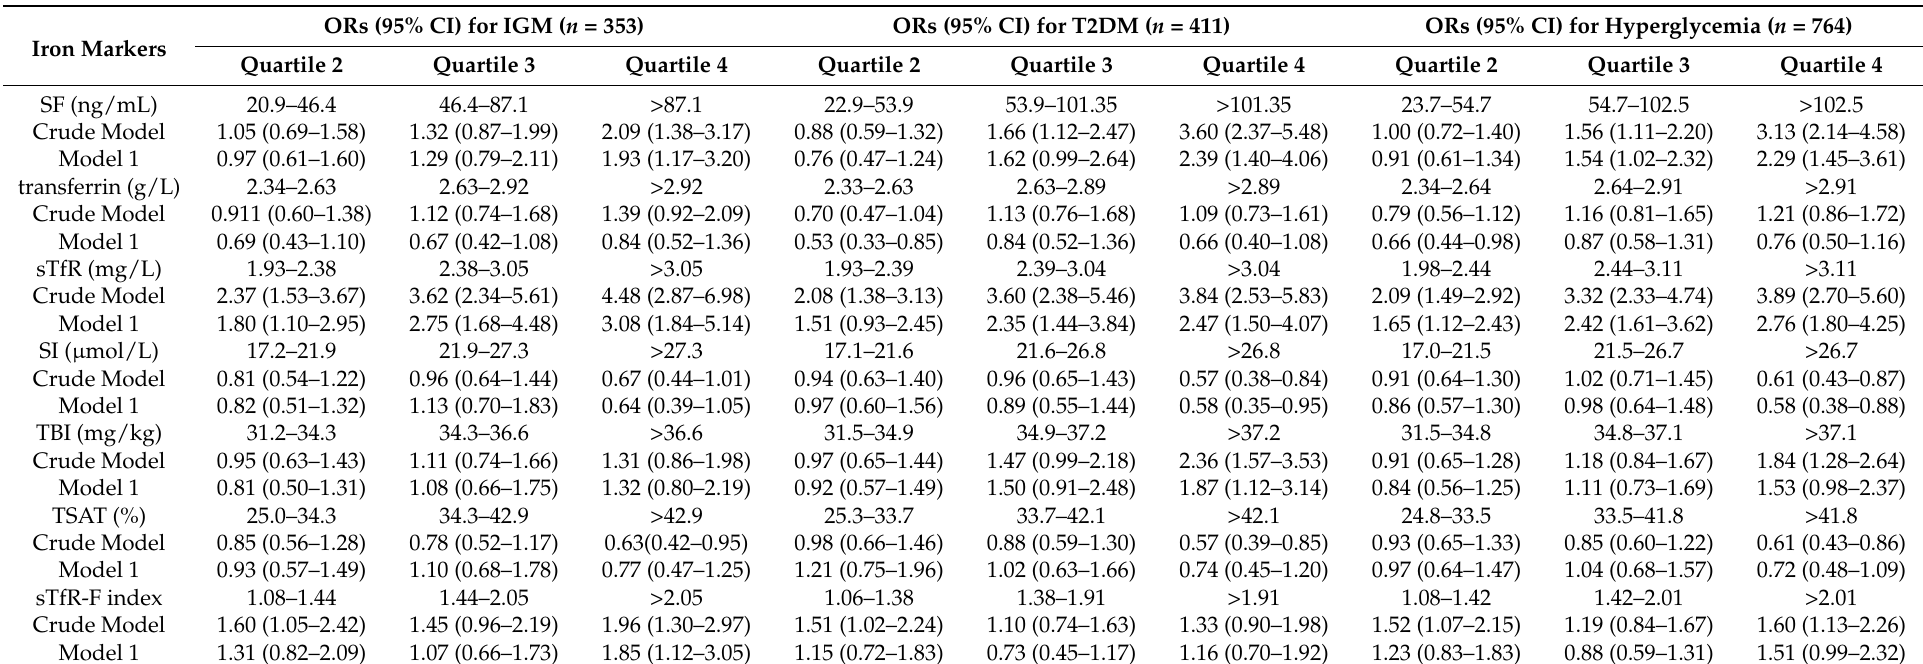
Table 4. Association between markers of iron metabolism and IGM, T2DM, or